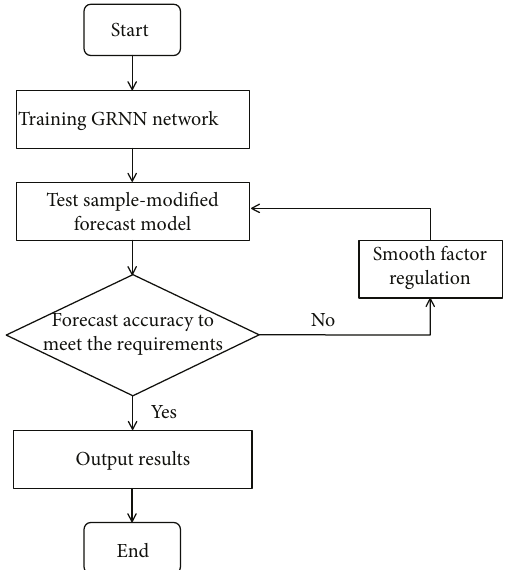
Figure 2: The process of heat transfer prediction of the GRNN network.